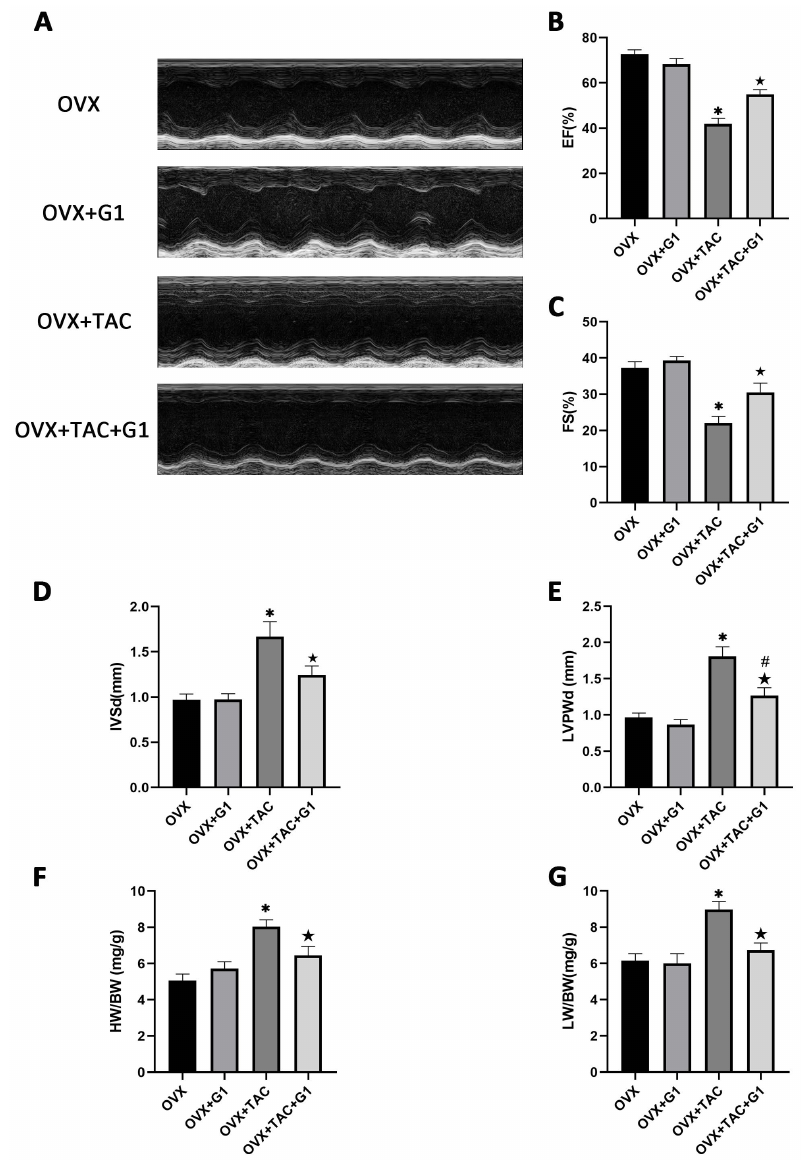
Figure 4. G1 improved cardiac function and attenuated cardiac hypertrophy in OVX + TAC mice by M-mode echocardiography. ( A ) Representative images of M-mode echocardiography in different groups. ( B ) EF. ( C ) FS. ( D ) IVSd. ( E ) LVPWd. ( F ) HB/BW. ( G ) LW/BW. The data is expressed as mean ± SEM and was analyzed by one-way ANOVA (n = 4). * p < 0.05 vs. OVX; # p < 0.05 vs. OVX + TAC; (cid:70) p < 0.05 vs. OVX +